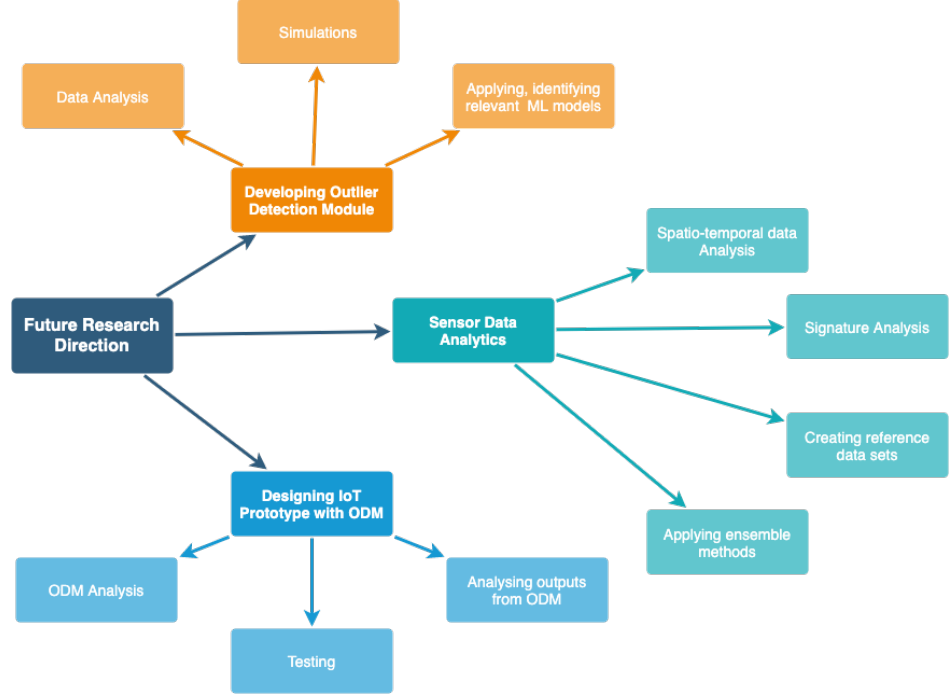
Figure 8. Future research directions in designing and developing Outlier Detection Modules (ODM) for the